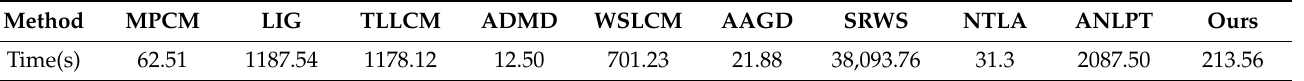
Table 10. Running time of different methods when the SNR is 1